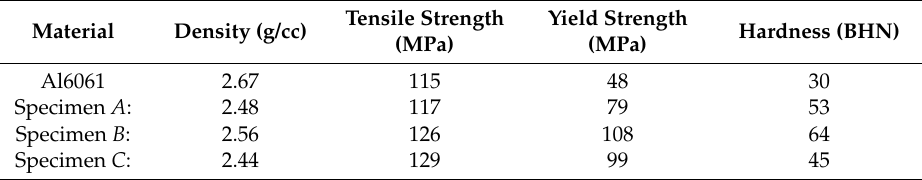
Table 3. Mechanical properties of the proposed hybrid MMC for different specimens.